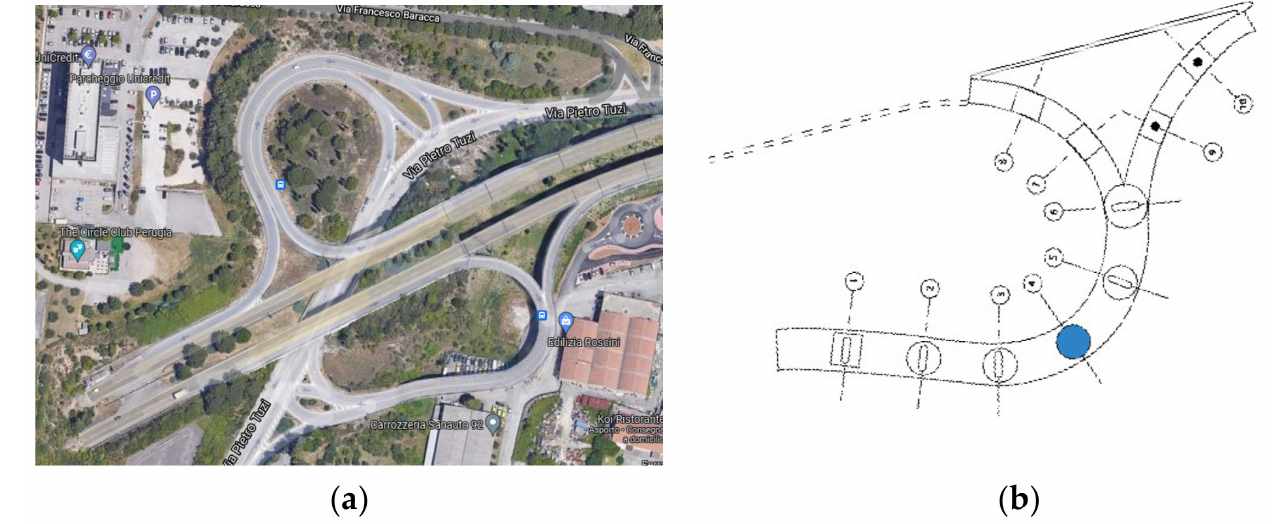
Figure 1. The figure shows: ( a ) the aerial view of the examined viaduct of the Perugia A1 motorway; and ( b ) the plan view of the considered sector where the blue circle indicates the considered pier (original